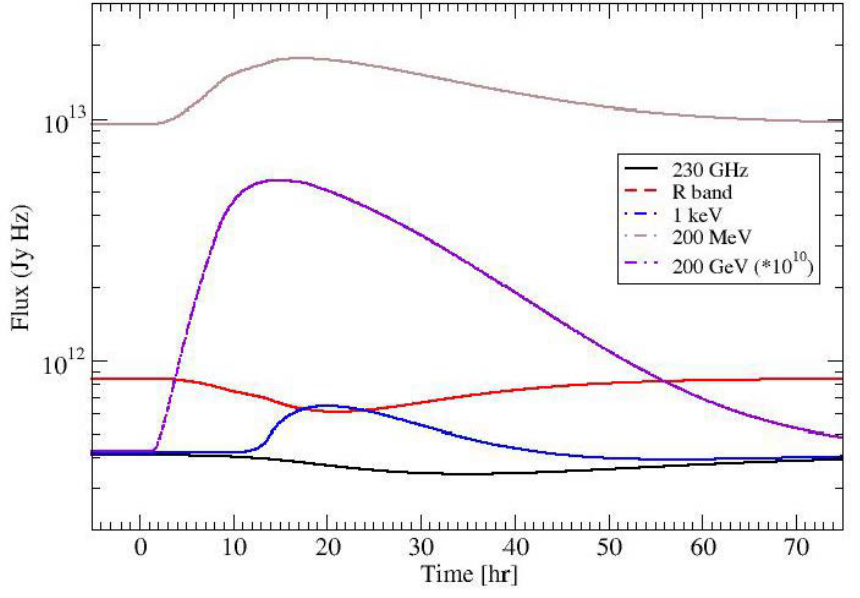
Figure 2. Model light curves in various frequency/energy bands resulting from the synchrotron mirror simulation illustrated in Figure 1 at the 5 representative frequencies/energies marked by the vertical dashed lines. Note that the very-high-energy (VHE, 200 GeV) γ -ray flux is scaled up by a factor of 10 10 in order to be visible on the